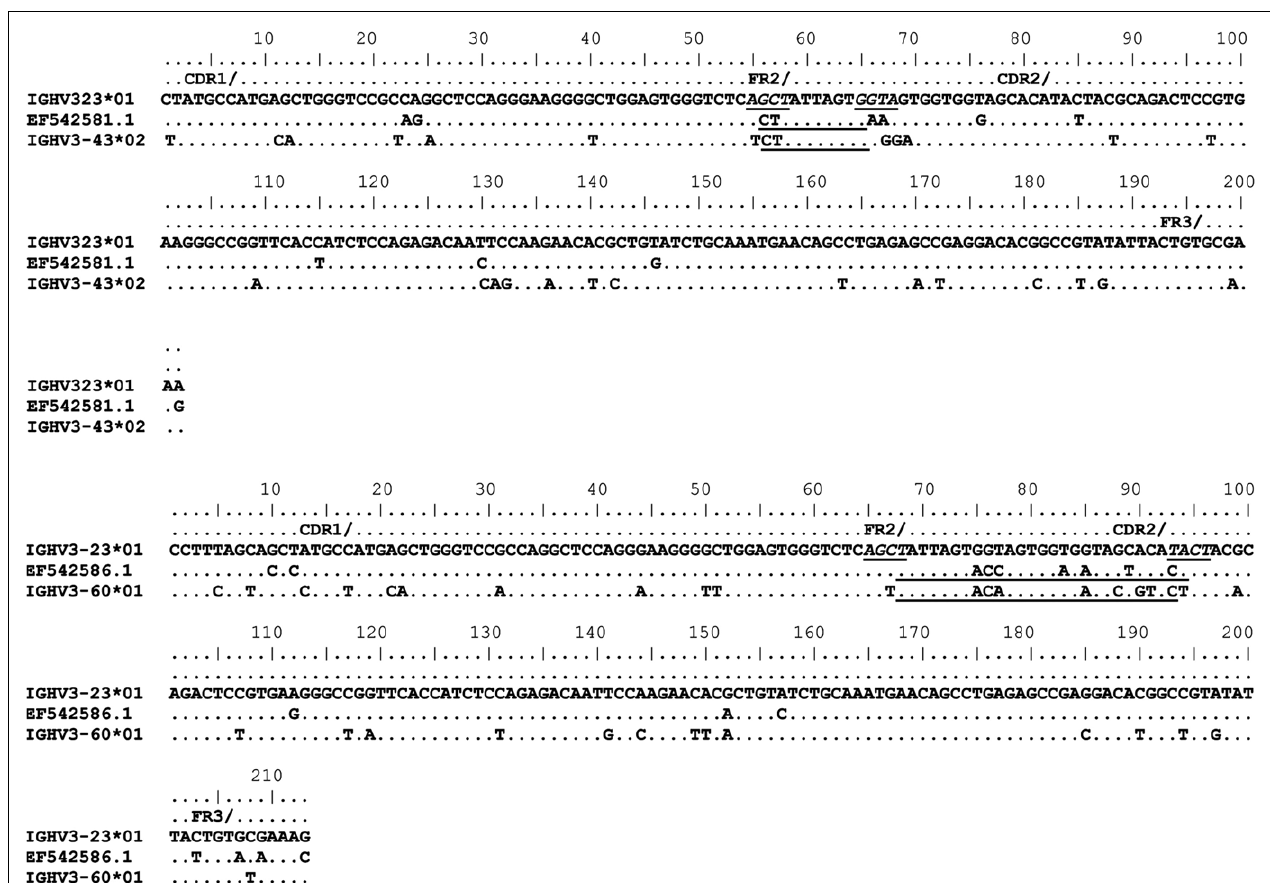
is the germline of rearranged IGHV3-23*01 gene sequences from healthy individuals (EF542581.1 and EF542586.1). Potential donor germline IGHV3 family gene segments are shown below the rearranged IGHV3-23*01 sequences. GCV-like tract is underlined. Flanking SHM/AID hotspot motifs are underlined and